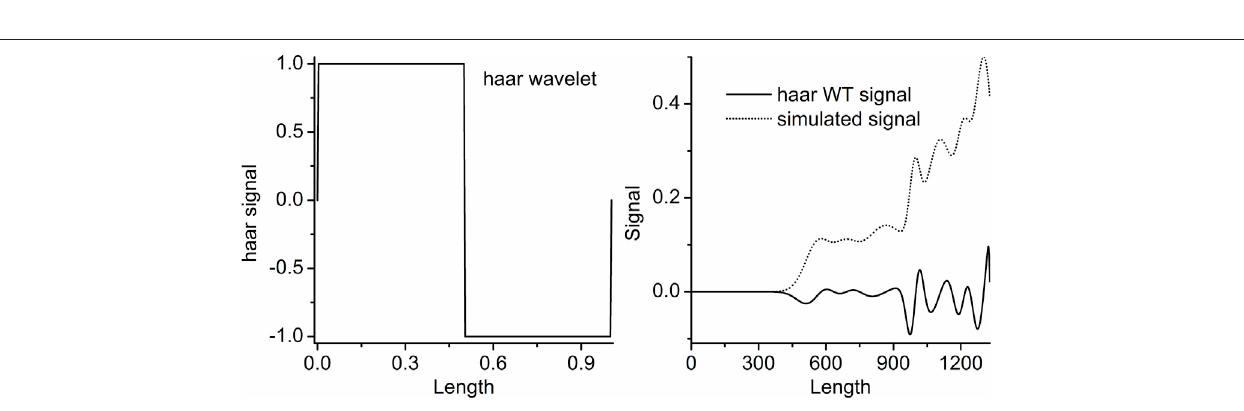
FIGURE 3 | Haar wavelet and the Haar WT result of the simulated